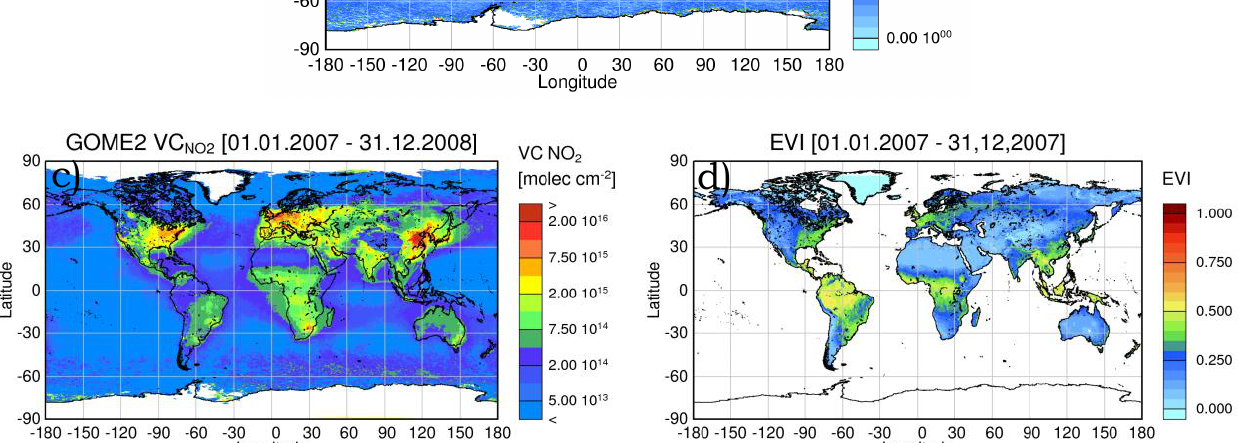
Fig. 1. Two years composite maps of the Vertical Column Densities (moleccm − 2 ) of (a) CHO.CHO, (b) HCHO, and (c) NO 2 retrieved using the radiance measurements of the GOME-2 instrument. Data gridded to 0.5 ◦ × 0 . 5 ◦ have been used for the following analysis. Panel (d) depicts the average Enhanced Vegetation Index (EVI) computed for the period 2007–2008 using MODIS data (http://modis-land.gsfc.